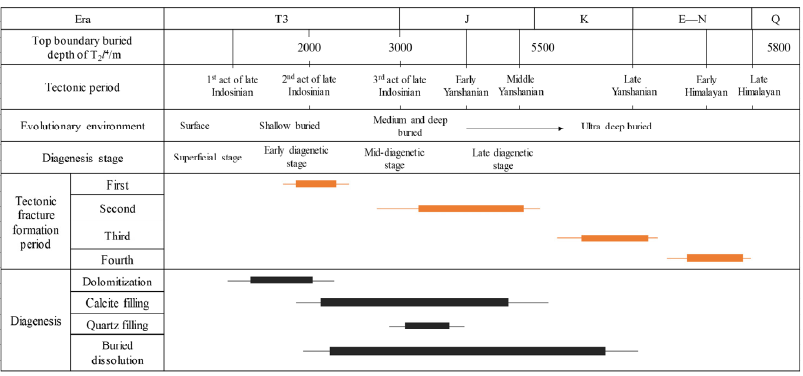
Figure 2. Sequence diagram of the tectonic fracture formation period and dissolution in the T 2 l 4 reservoir.